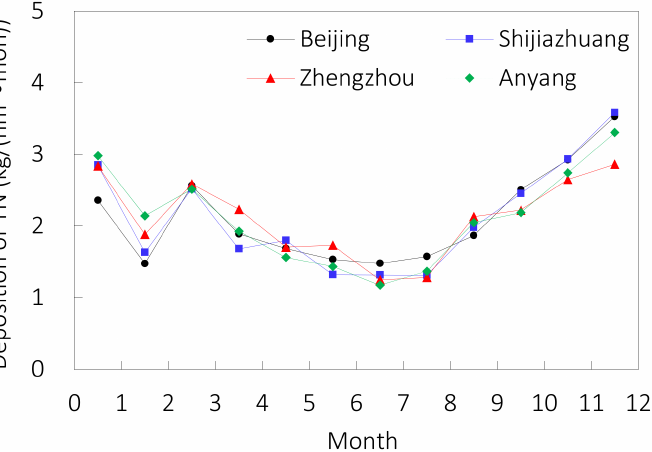
Figure 4. Multi-year monthly average atmospheric nitrogen deposition in parts of regions along the MR-SNWDP.